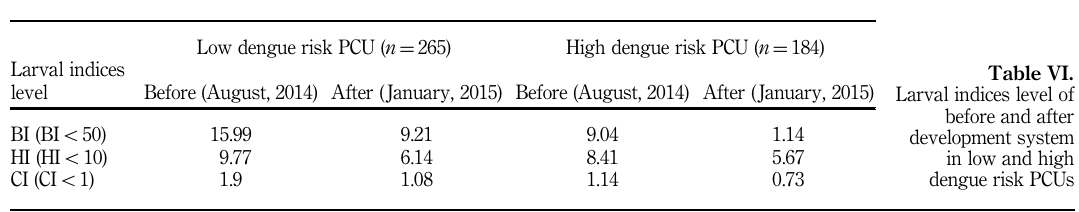
Table V. VHV ’ s problems, barriers and needs support in low and